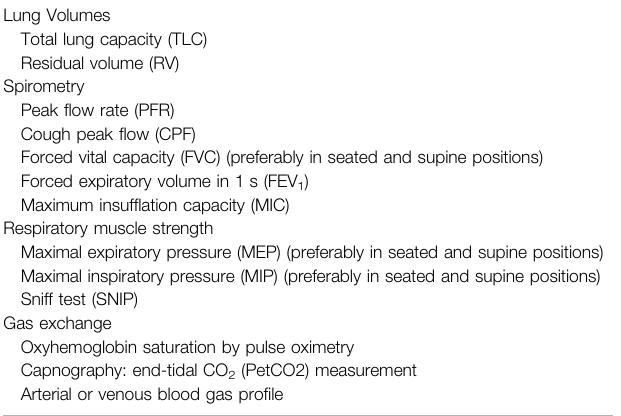
TABLE 1 | Respiratory function tests commonly used to evaluate individuals with neuromuscular disorders. Lung Volumes Total lung capacity (TLC) Residual volume (RV) Spirometry